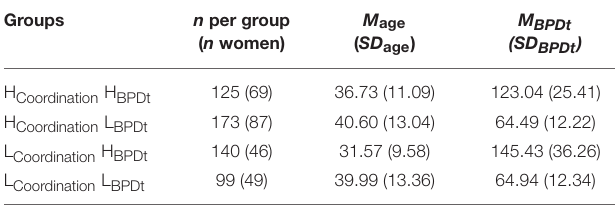
TABLE 1 | Descriptive statistics for comparison groups in experiment